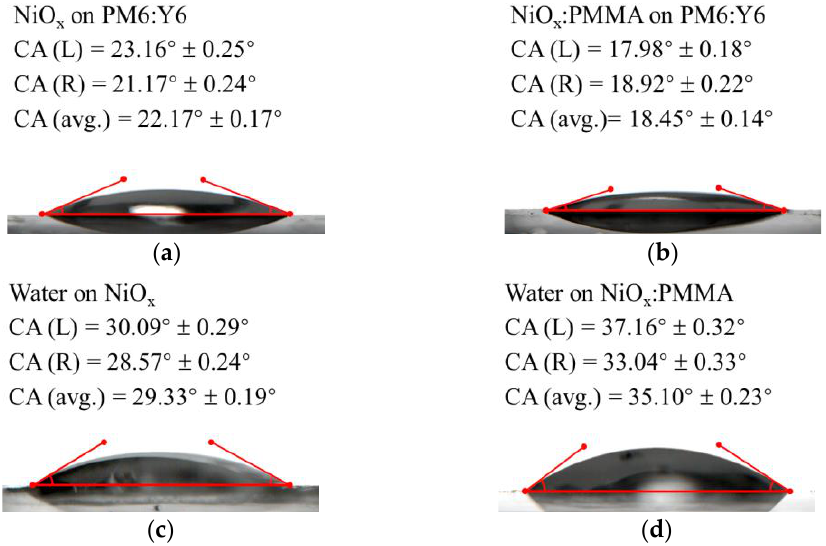
Figure 7. ( a ) Contact angle (CA) image of NiO x NP dispersions on PM6:Y6 film , ( b ) CA image of NiO x :PMMA NP dispersions on PM6:Y6 film , ( c ) CA image of water on NiO x HTL film , and ( d ) CA image of water on NiO x :PMMA HTL film. Each CA value was obtained from 5 attempts of measurement.